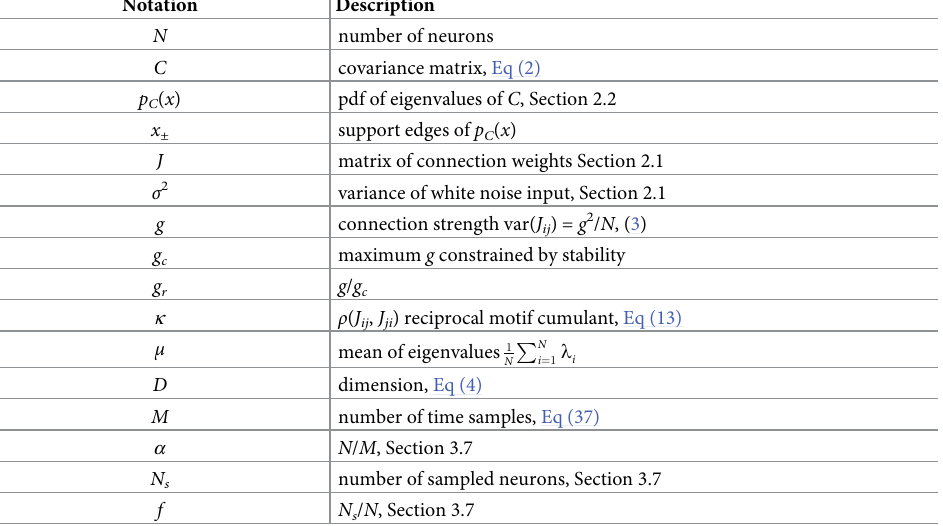
Table 1. List of